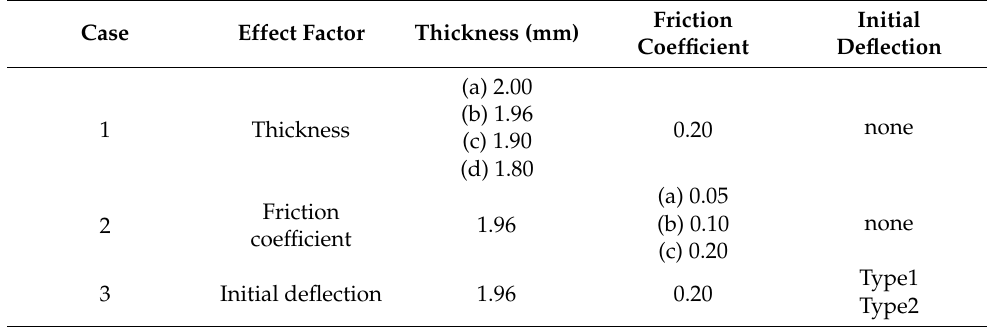
Table 4. Summary of the case study parameters.